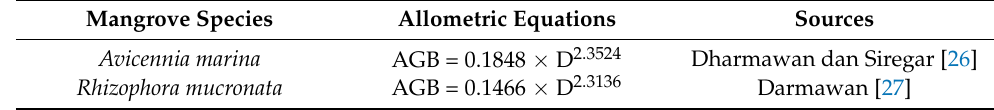
Table 1. Allometric equations for above-ground biomass estimation. Mangrove Species Allometric Equations Sources